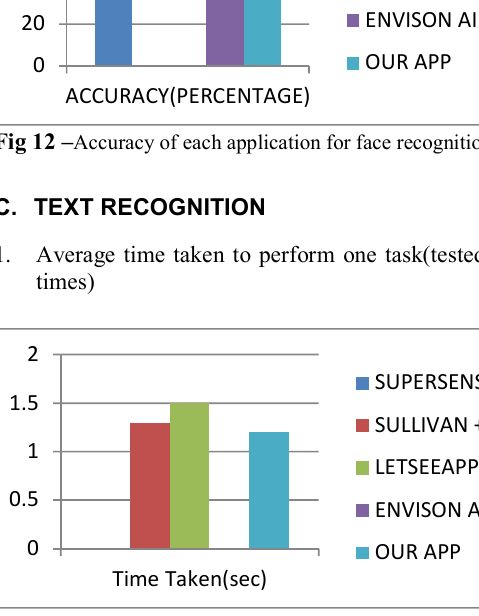
Fig 13 – Time taken by each application for text